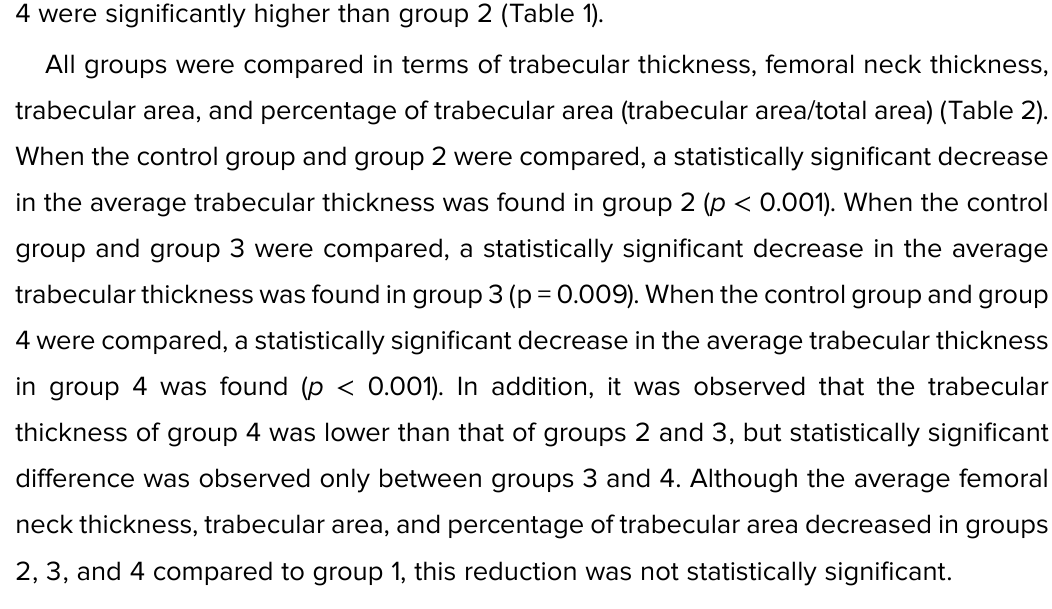
TABLE 2: Histomorphometric parameters among the groups. Group 1 Group 2 Group